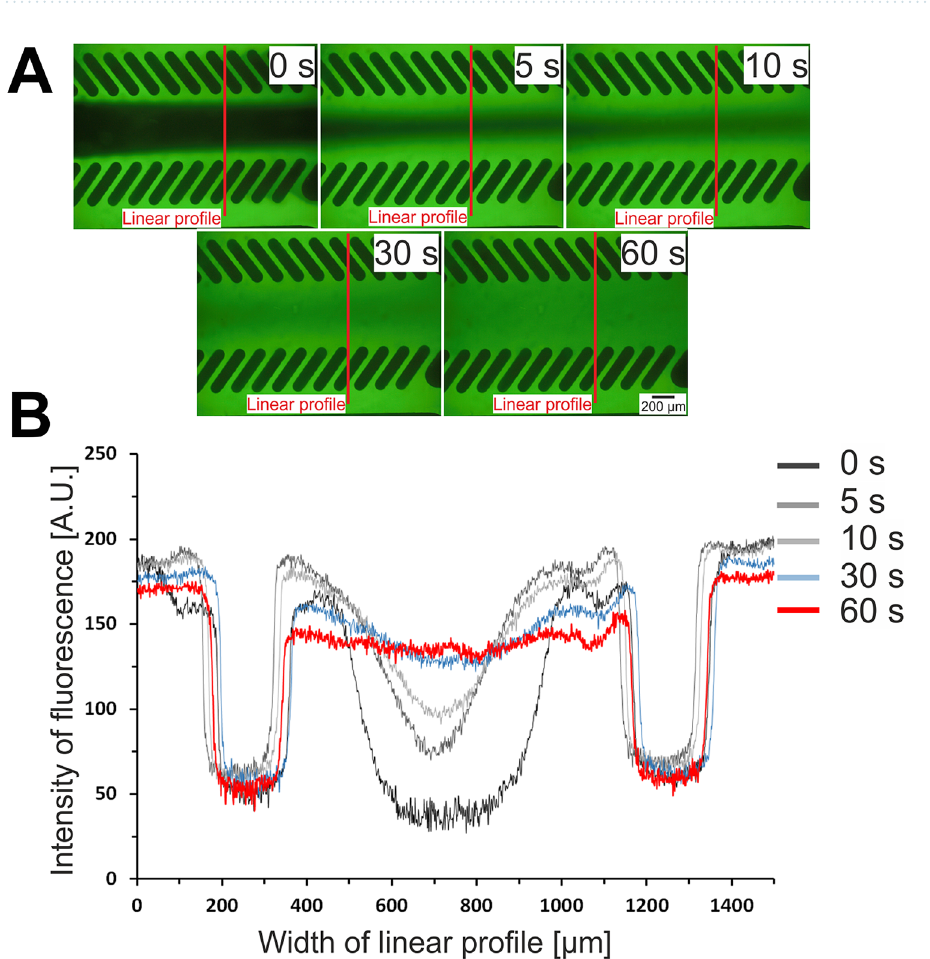
Figure 2. ( A ) A visualization of the diffusion of culture medium from the side microchannels into the culture microchamber using fluorescein solution. ( B ) Linear profile of changes in intensity of fluorescence in the culture